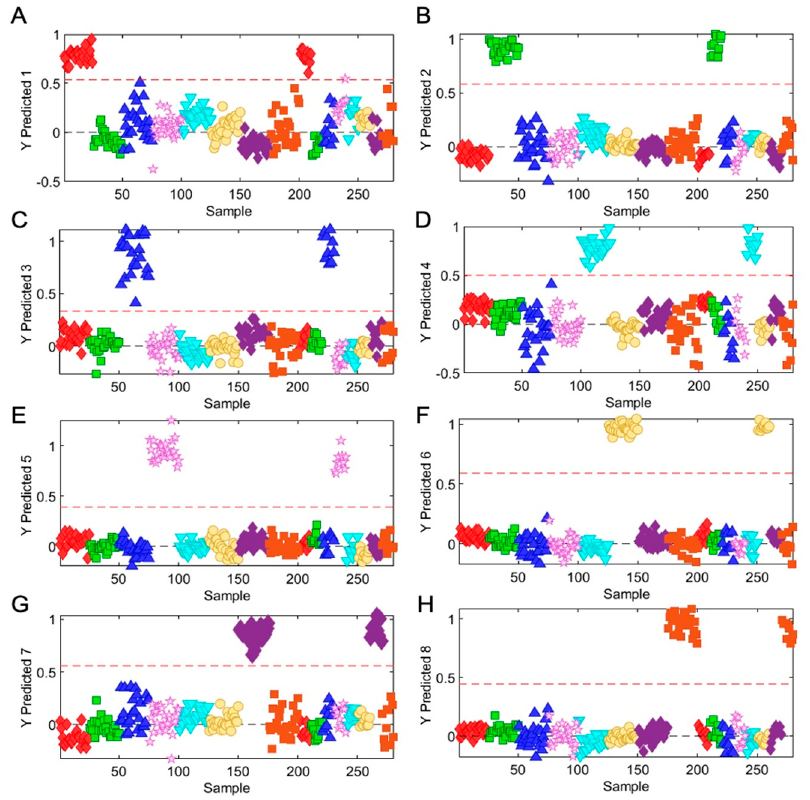
Figure 6. Predicted models for Ocimum samples by PLS-DA model. ( A ) HT-v1—Hybrid Tulsi vari- ety 1; ( B ) HT-v2—Hybrid Tulsi variety 2; ( C ) OB-v1— Ocimum basilicum variety 1; ( D ) OB-v2— Oci-